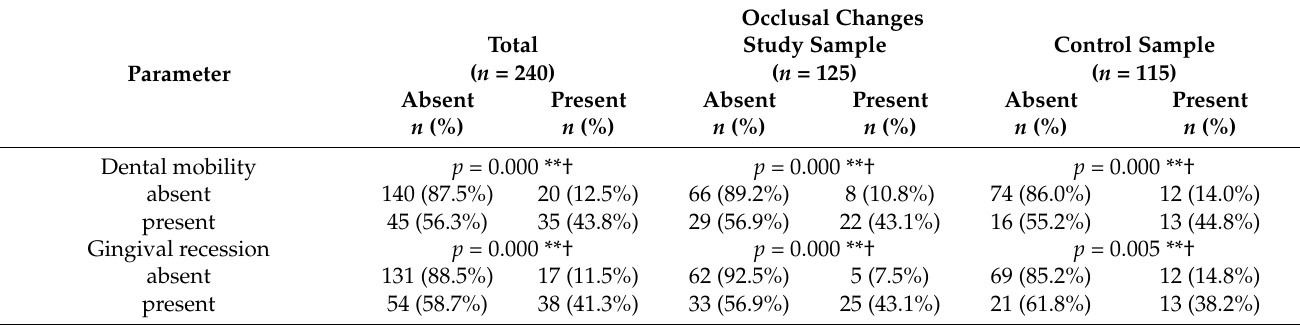
Table 6. The occlusal changes presence by dental mobility and gingival recession in the investigated samples.